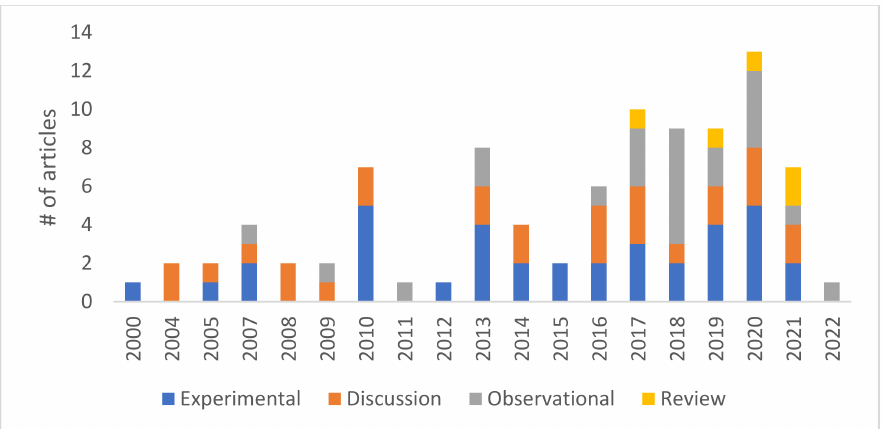
Figure 3. Publication dates and types for all articles ( n =